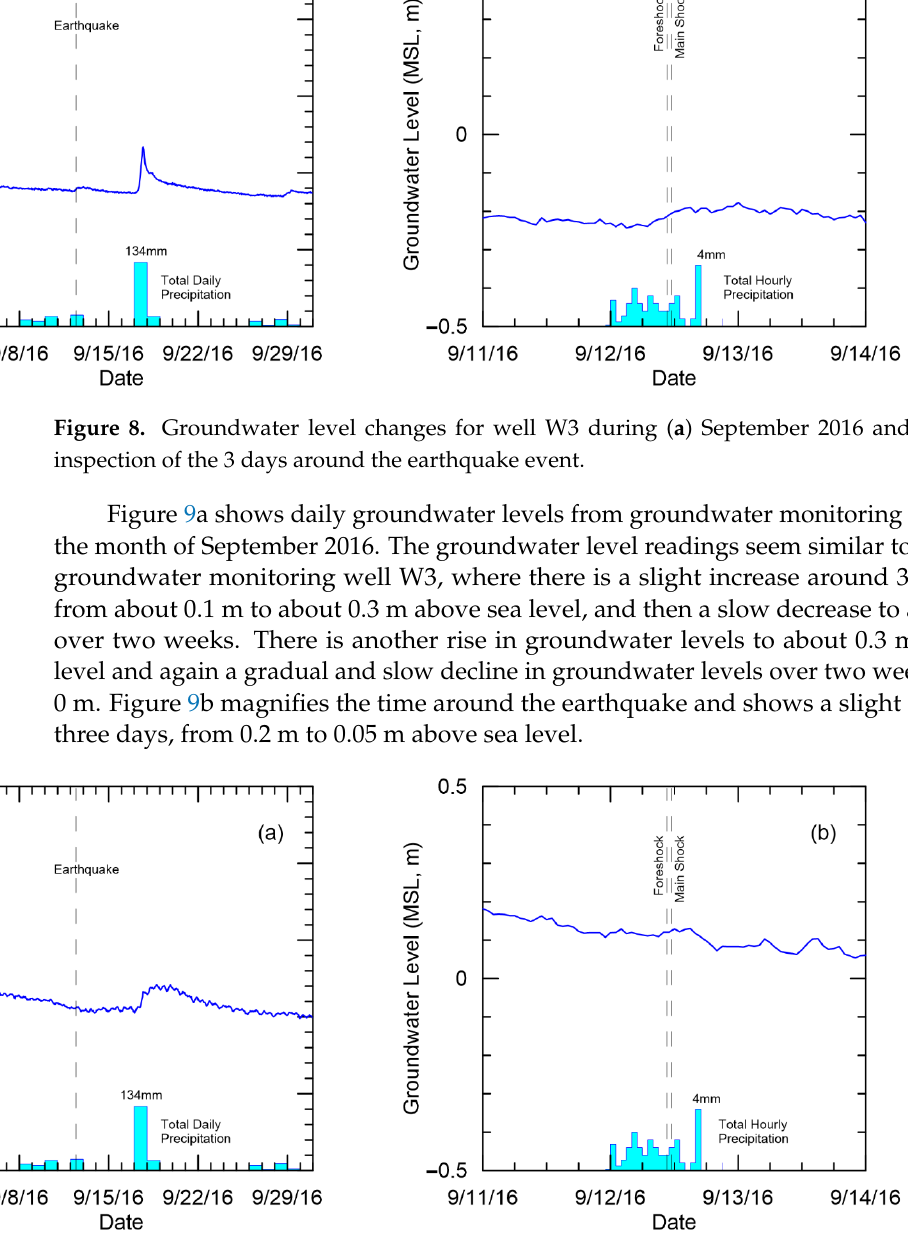
Figure 9. Groundwater level changes for well W4 during ( a ) September 2016 and ( b ) a closer inspec- tion of the 3 days around the earthquake